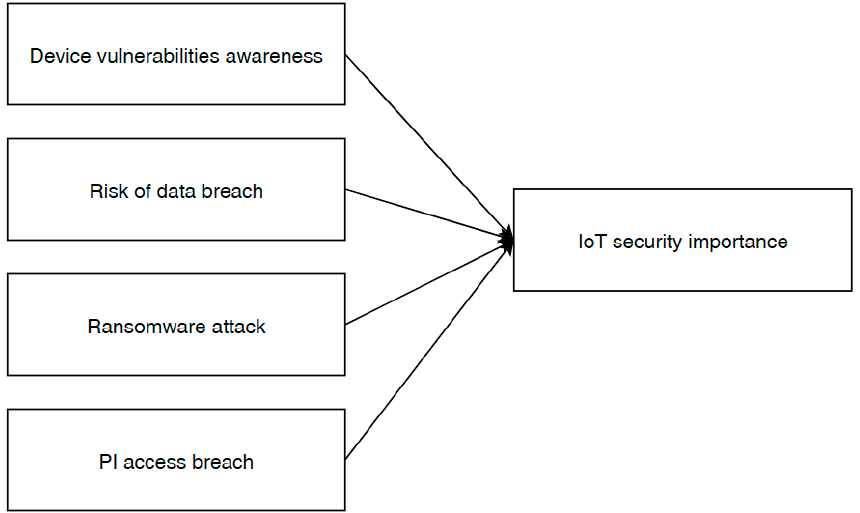
Figure 1. Research Figure 1. Research model.